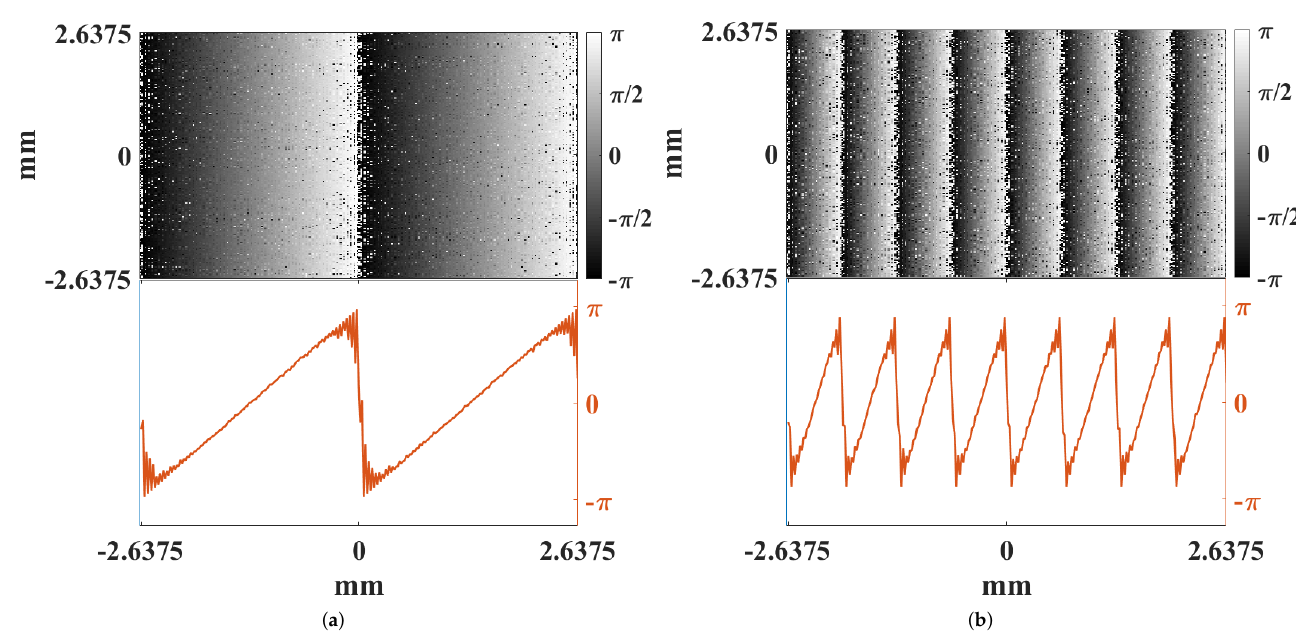
Figure 3. Computed phase tilts at the scatterer due to circular shifts of the SLM phase mask in the focal plane setup. The phase at the scatterer is simulated for a given phase mask, and then the phase mask is shifted, creating phase tilts at the scatterer. The SLM phase mask is circularly shifted 8 pixels in ( a ) and 32 pixels in ( b ). What is shown is the the phase differences at the scatterer’s surface between the unshifted and shifted